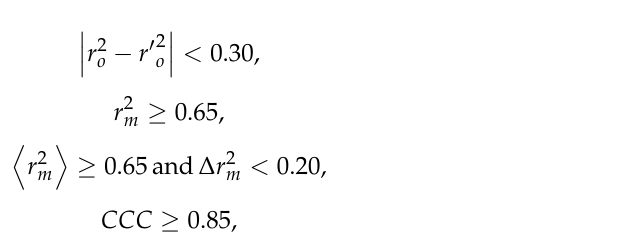
Supplementary Materials: Table S1. Selected compounds for this study, their names, SMILES strings, CAS numbers, observed log ER values and predicted values by SVR A, SVR B, and HSVR, data partitions, and references; Table S2. Optimal runtime parameters for the SVR models; Figure S1. Molecular distribution for the samples in the training set (solid circle) and test set (open square) in the chemical space spanned by three principal components; Figure S2. Histograms of: (A) observed log ER; (B) molecular weight (MW); (C) polar surface area (PSA); (D) number of hydrogen bond acceptor (HBA); and (E) number of hydrogen bond donor (HBD) in density form for all molecules in the training set and test